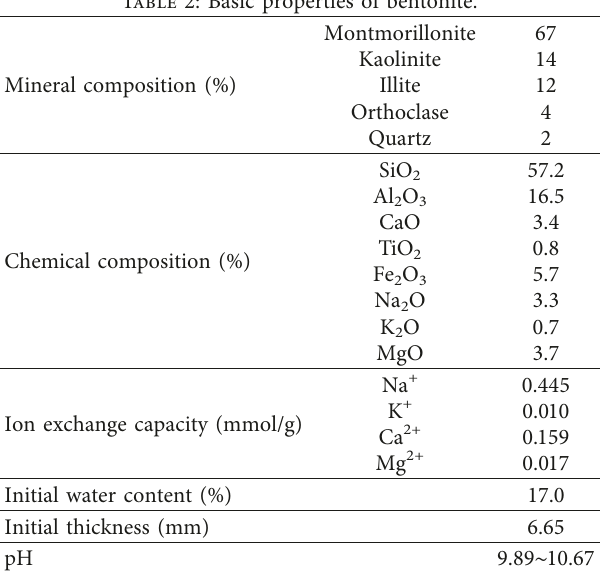
Table 2: Basic properties of